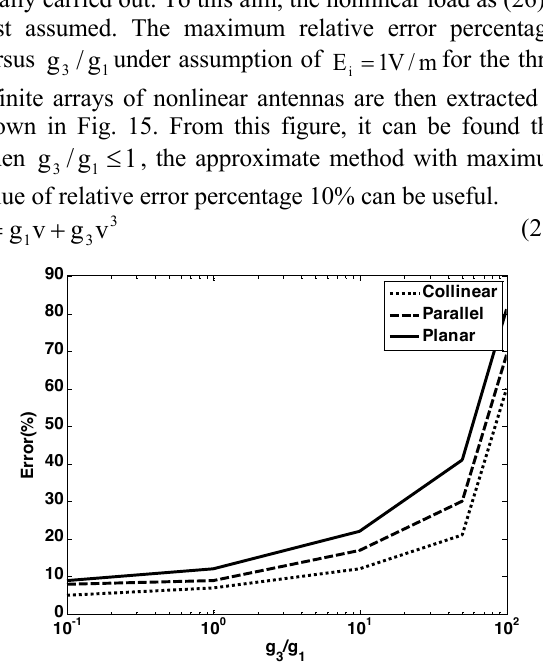
FIGURE 15. Maximum value of the relative error of the approximate method versus normalized nonlinearity ( ) for infinite parallel, collinear and planar